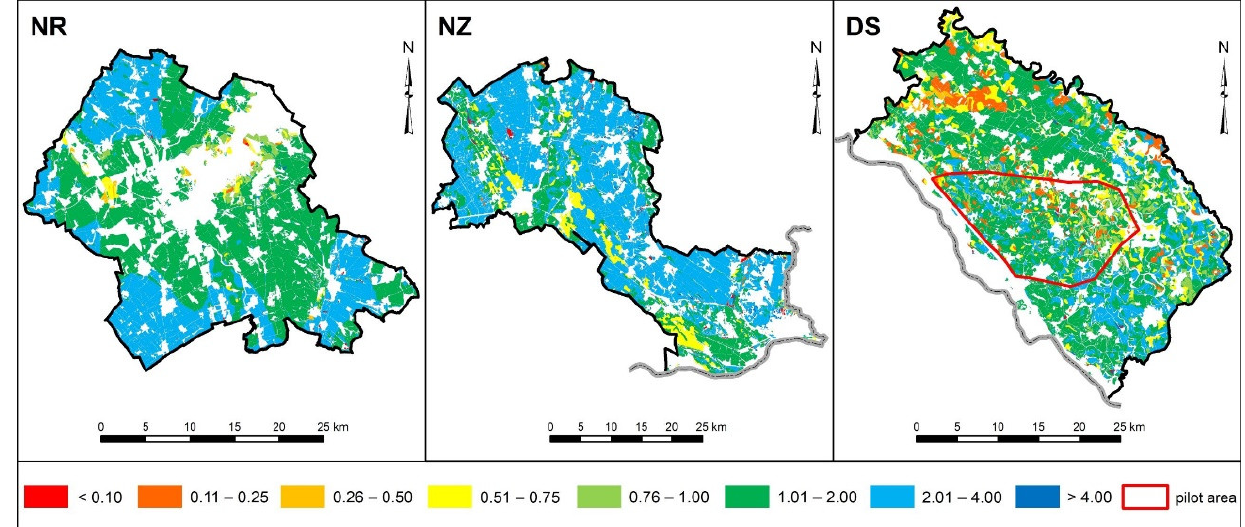
Figure 5. Residence times of percolation water in the agricultural soil (in years). The amount of leachable nitrogen after losses via denitrification in the soil rooting zone is illustrated in Figure 6. As it can be seen, the lowest values are detected in district Dunajská Streda, followed by the Nové Zámky and Nitra districts. The share of UAL with displaceable nitrogen below 10 kg ha −1 decreases in the order NZ (94.1%) > DS (80.5%) > NR (67.7%). In the pilot area, this share is little bit higher than in the whole DS district (85.3%).